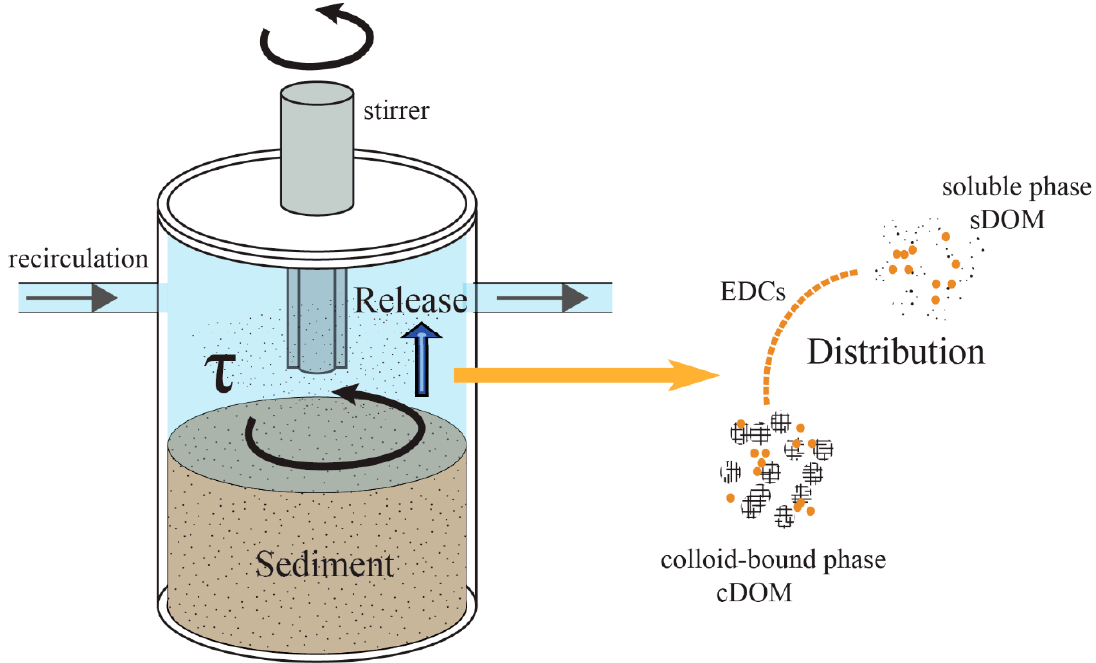
Figure 1. The scheme of the hydrodynamic water chamber mesocosm. EDCs: endocrine-disrupting chemicals; DOM: dissolved organic matter; sDOM: DOM in in soluble phase; cDOM: DOM in colloid-bound phase.